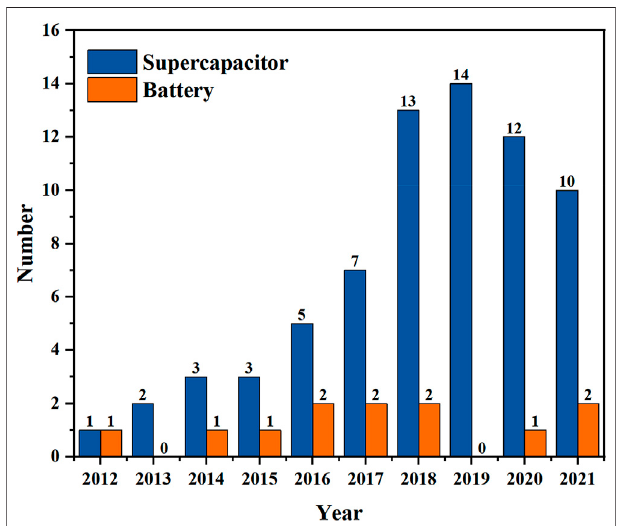
FIGURE 1 | Trends in the number of publications on metal nanowire- based current collector for fl exible energy storage devices over the past 10